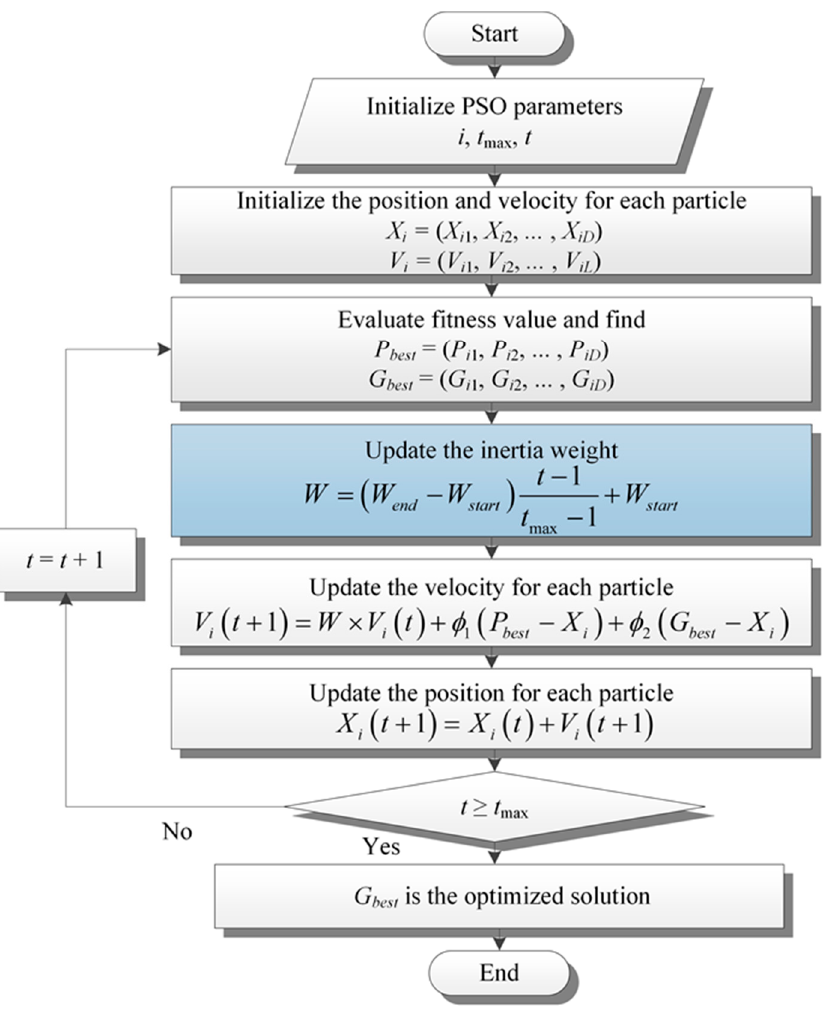
Figure 3. Flow chart of improved PSO algorithm.